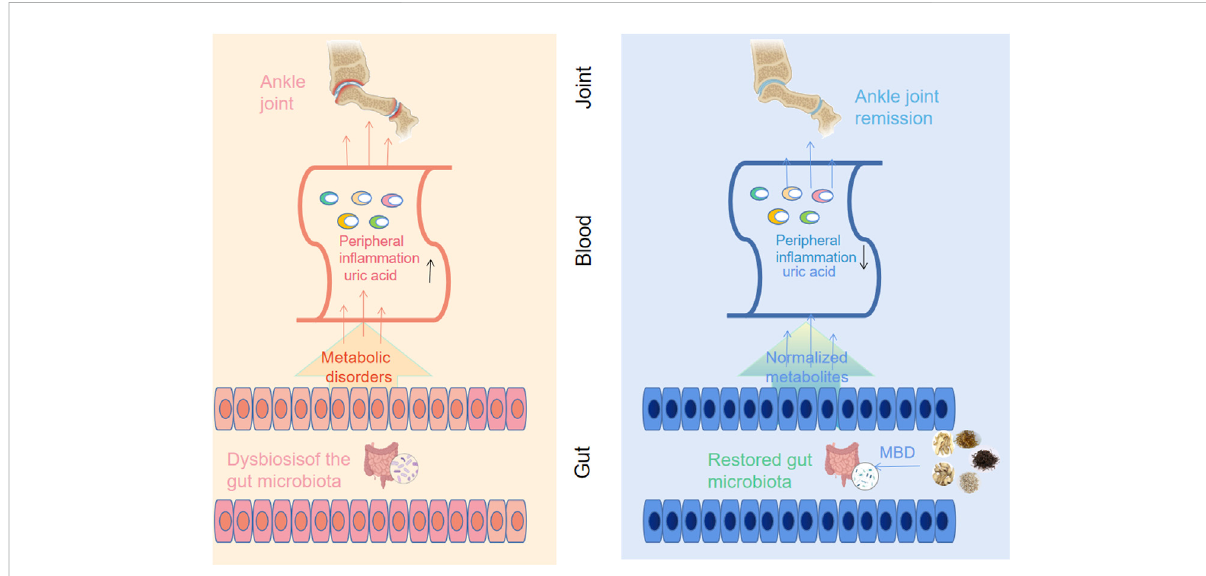
FIGURE 9 CorrelationsofarthritiswithgutmicrobiotaandUAmetabolism.Alongwiththedepositionofsodiumurateinthejointcavity,intestinalbacterial disordersduring theprogressionofAGAleadtoabnormaluricacidmetabolism andariseinserumuricacidlevels,accompaniedbyanin fl ammatory response (left panel). Oral administration of MBD with added fl avour can restore the disorder of intestinal fl ora caused by AGA, normalize the metabolic disorder and reduce the peripheral in fl ammatory response, thus improving the symptoms of AGA (right